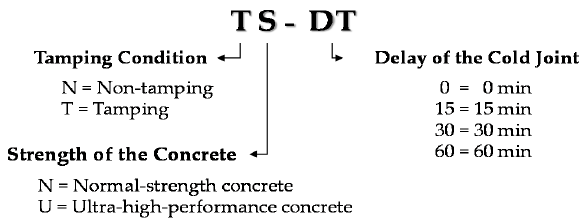
Figure 1. Overview of specimen nomenclature. Table 2. Experimental variables.